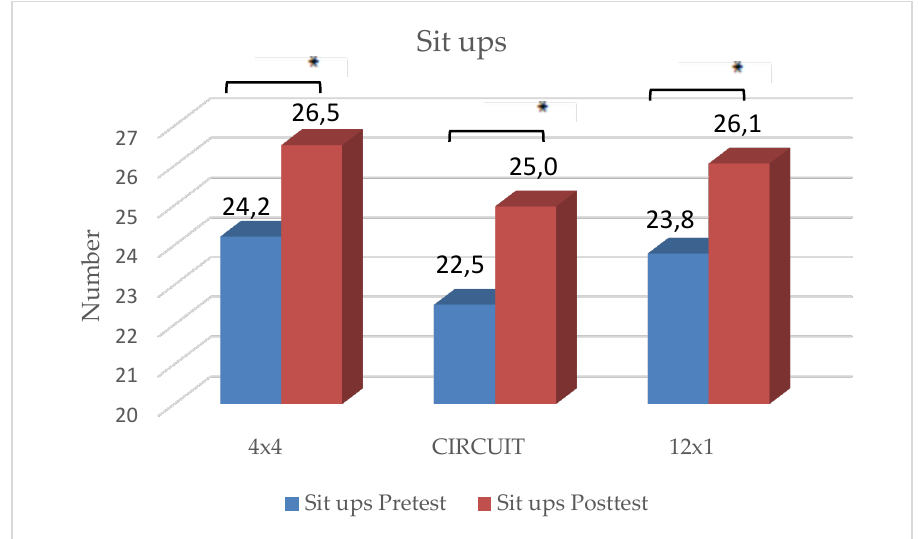
Figure 3. Changes in number of pushups within intervention groups . * Significant difference between pre- and posttest ( p < 0.05).